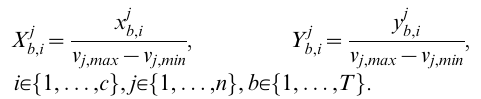
Figure 3. Empirical convergence for C. thermocellum iSR432. (a) Convergence according to the Geweke diagnostic. (b) Convergence according to the Heidelberger-Welch diagnostic. Convergence for optGpSampler is observed at approximately 500 steps. For gpSampler , both diagnostics only agree on convergence after k =5000 steps. Notice the higher HW convergence fraction of the latter at k =50 steps and at k =5000 steps compared to the steps in between.